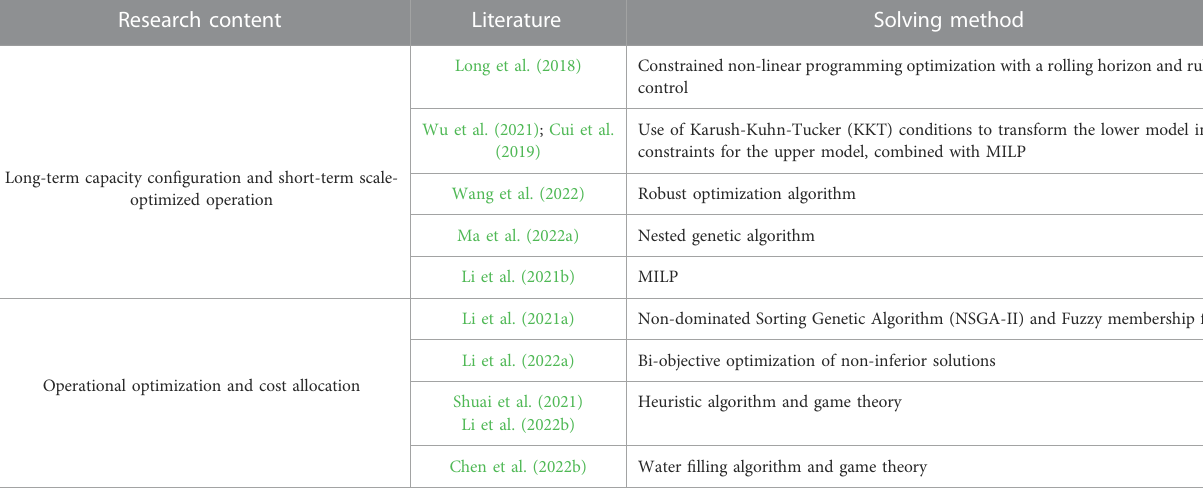
TABLE 1 Common solutions to multi-stage problems of shared energy storage optimization.